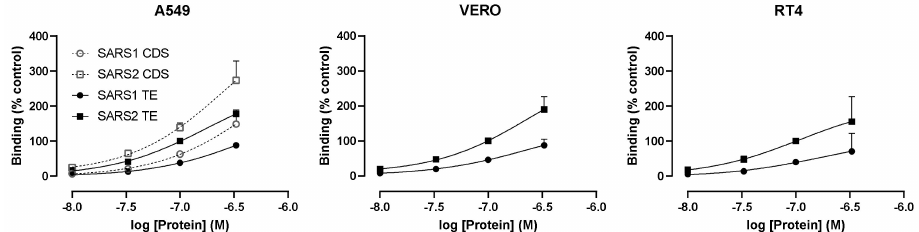
Figure 5. wtS1S2 from SARS-CoV-1 binds more weakly to cells than SARS-CoV-2 wtS1S2. A549, RT4 and VERO E6/TMPRSS2 cells were harvested by either trypsin/EDTA (TE; filled symbols) or non-enzymatic cell dissociation solution (CDS; open symbols) and then incubated with the stated concentrations of wtS1S2 from SARS-CoV-1 (squares) or SARS-CoV-2 (circles) for 60 min, before staining with anti-His6 secondary antibody labelled with Dylight 488. The data are shown relative to 100 nM SARS-CoV-2 wtS1S2 and are the means ± SEM from 3–4 independent experiments performed in